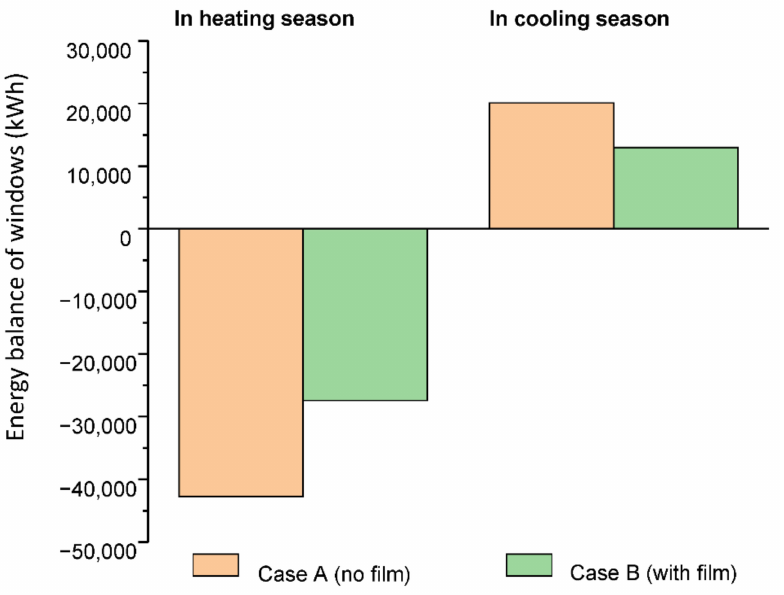
Figure 22. Comparison of the energy balance of windows (including solar radiation) in case A (no low-E film) and case B (with low-E